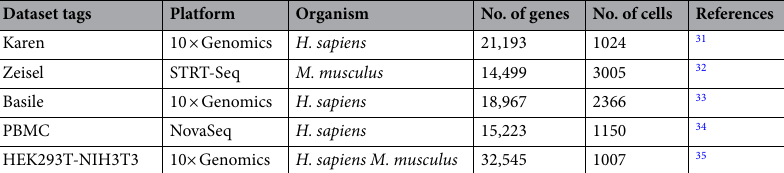
Table 1. List of datasets selected for representational downstream functional analyses.